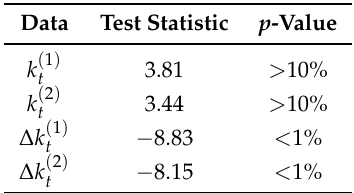
Table 2. Augmented Dickey–Fuller test